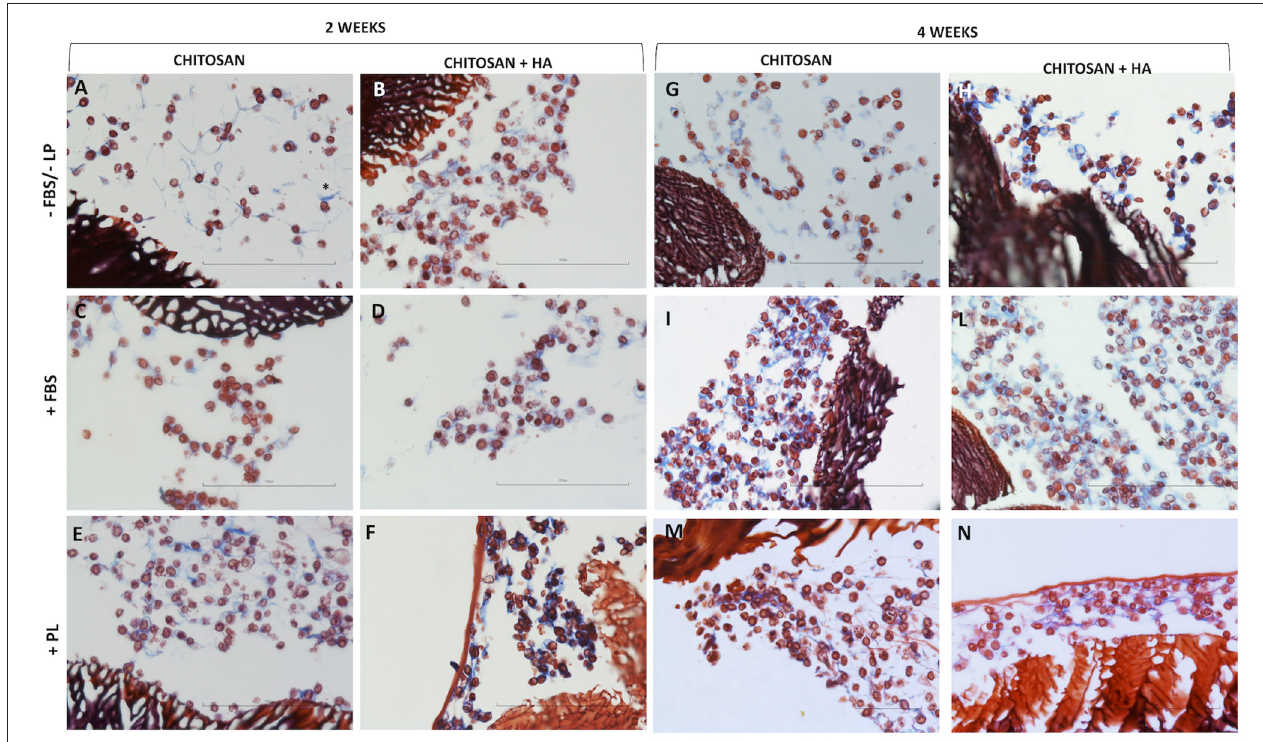
FIGURE 4 | Light microscopy of chitosan scaffolds (A,C,E) and chitosan scaffolds prepared with hyaluronic acid (HA) (B,D,F,H,L,N) with chondrocytes cultured in different conditions after 2 and 4 weeks. –FBS/–PL (A,B,G,H) ; + FBS (C,D,I,L) ; + PL (E,F,M,N) . Masson’s trichrome staining, Scale bar = 100 µ m.